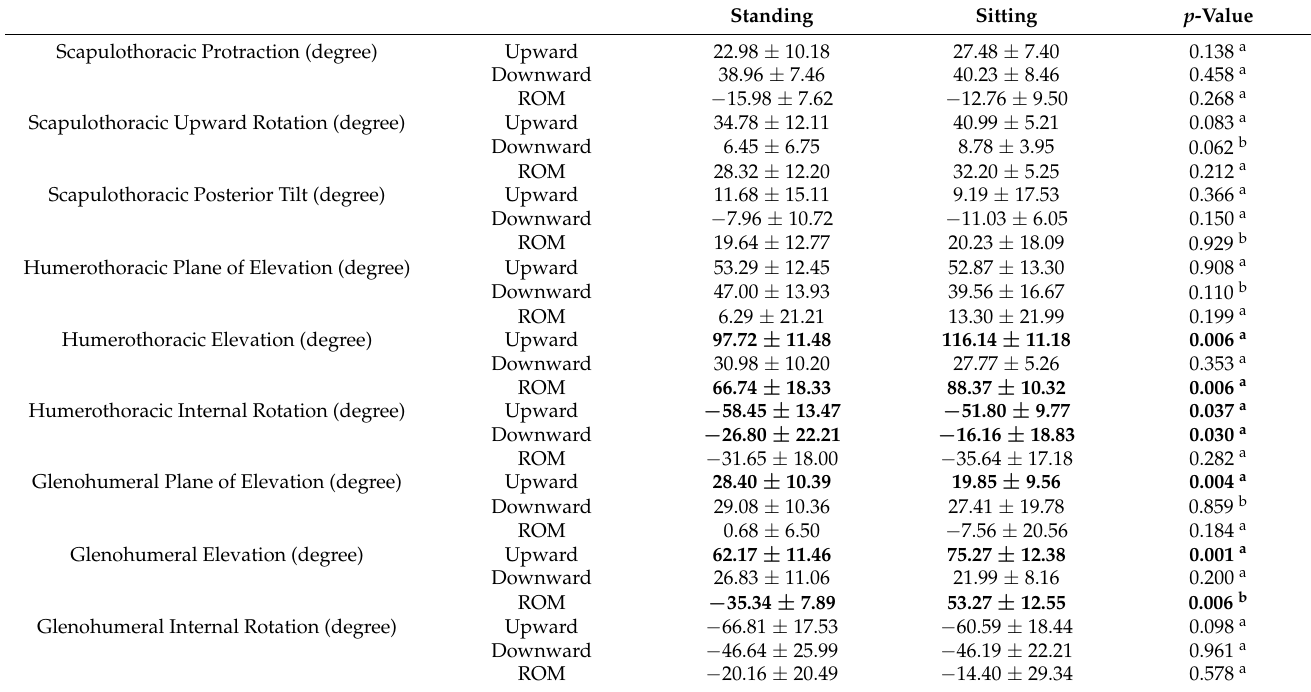
The values are presented as mean ± standard deviation. Upward: the time point when the sensor attached to forearm located at the most upward; Downward: the time point when the sensor attached to forearm located at the most downward; ROM: the difference between the value at Upward and that at Downward ([Upward]—